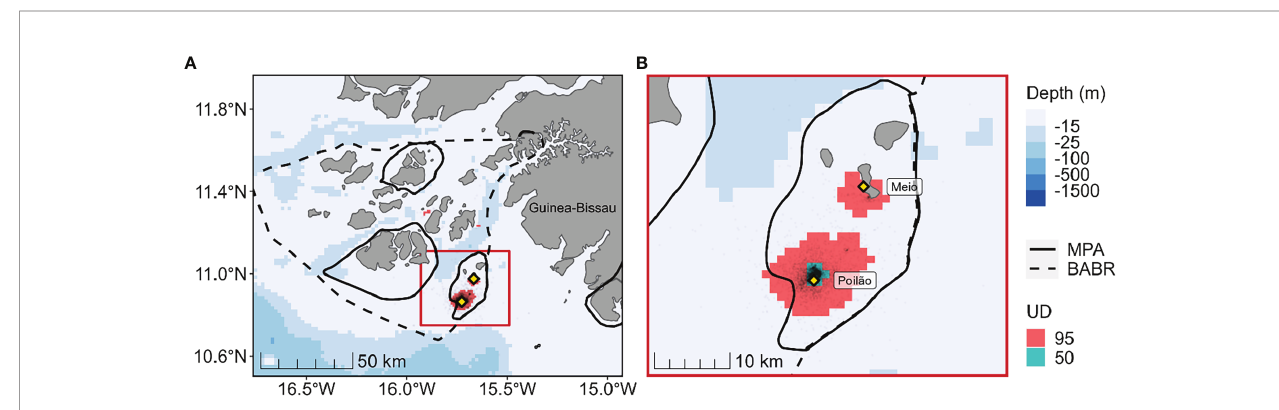
FIGURE 2 | (A) Distribution of 40 female green turtles (Chelonia mydas) tracked during internesting. Yellow diamonds indicate the nesting sites where satellite tags were deployed. The 95% (red) and 50% (blue-green) utilization distribution areas are shown, respectively signifying the population-level home range and core-use areas during internesting. The bold solid lines show the limits of existing marine protected areas (MPAs) and the dashed line shows the extent of the Bolama-Bijago ́ s Archipelago Biosphere Reserve (BABR). (B) Inset showing close-up of distribution around the nesting